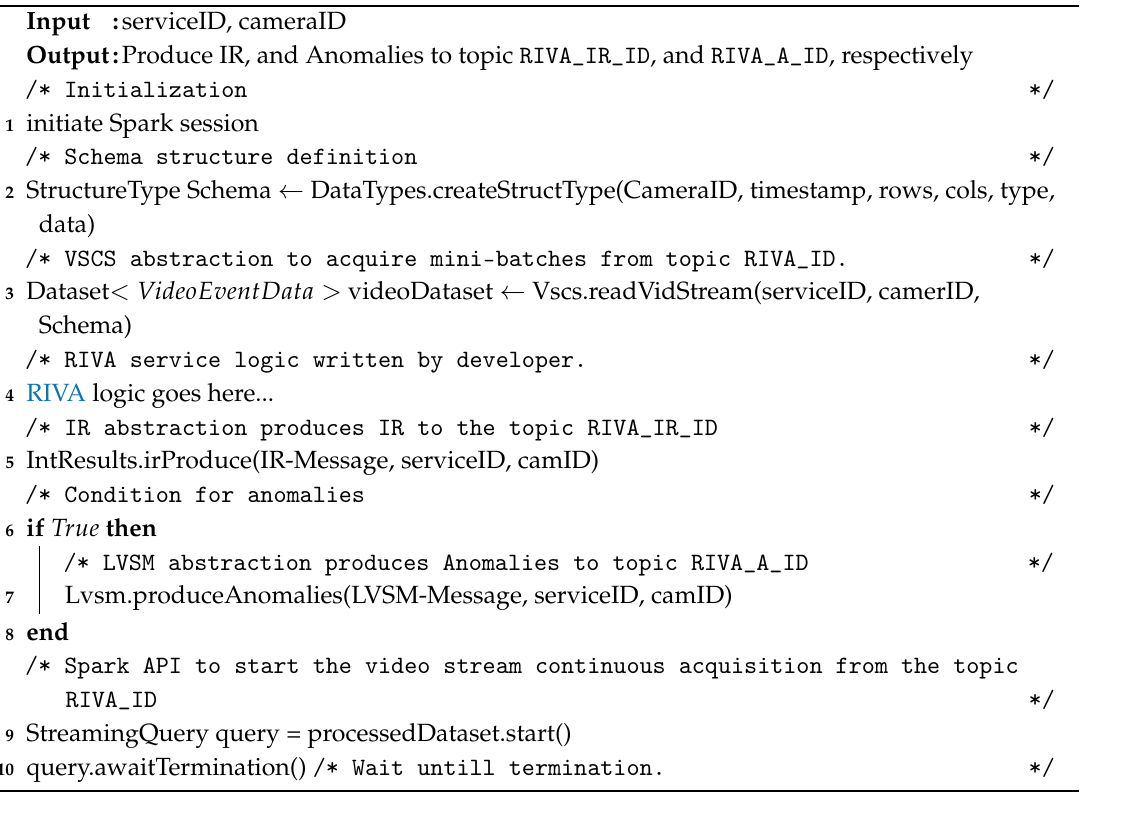
Algorithm 2: rivaServiceTemplate(serviceID,